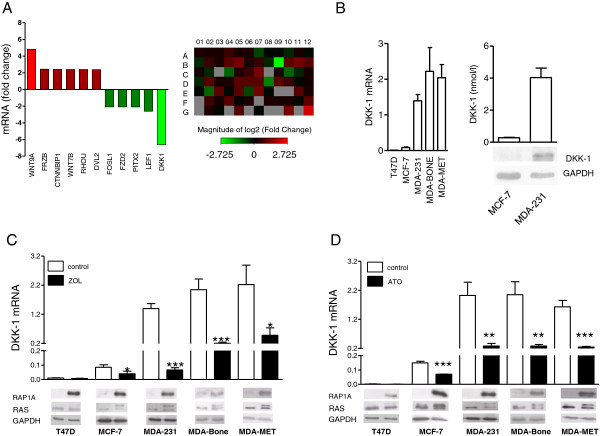
Dickkopf-1 is a target of zoledronic acid and atorvastatin in breast cancer cells in vitro. (A) Results from a WNT PCR array define Dickkopf-1 (DKK-1) as a target of zoledronic acid. MDA-231 cells were treated with zoledronic acid (100 μM) for 24 hours and assessed by a WNT array. A heat map of all tested genes is shown on the right: green, increased expression compared with control; red, decreased expression compared with control; grey, nondetectable gene. All genes that were regulated at least twofold are separately depicted on the left. (B) Basal expression of DKK-1 in different breast cancer cell lines assessed by polymerase chain reaction (PCR), enzyme-linked immunosorbent assay (ELISA) and western Blot. Glyceraldehyde 3-phosphate dehydrogenase (GAPDH) is a loading control. (C), (D) Suppression of DKK-1 by zoledronic acid (ZOL; 100 μM) and atorvastatin (ATO; 10 μM) after 24 hours of exposure was confirmed in multiple cell lines. Assessment of unfarnesylated RAS (upper band) and ungeranylated RAP1A confirmed mevalonate pathway inhibition. Representative blots are shown. GAPDH is used as a loading control. Data for PCR and ELISA are shown as mean ± standard deviation of three independent experiments. *P < 0.05; **P < 0.01; ***P < 0.001.